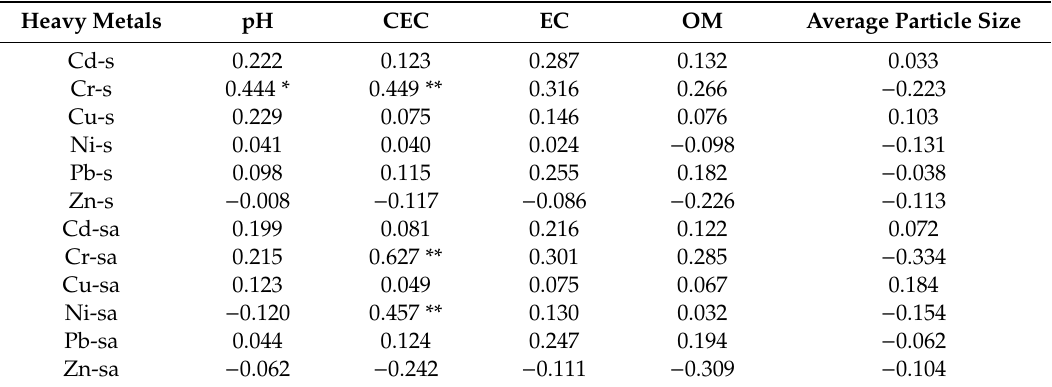
Table 6. The correlation between heavy mental concentration and soil properties.